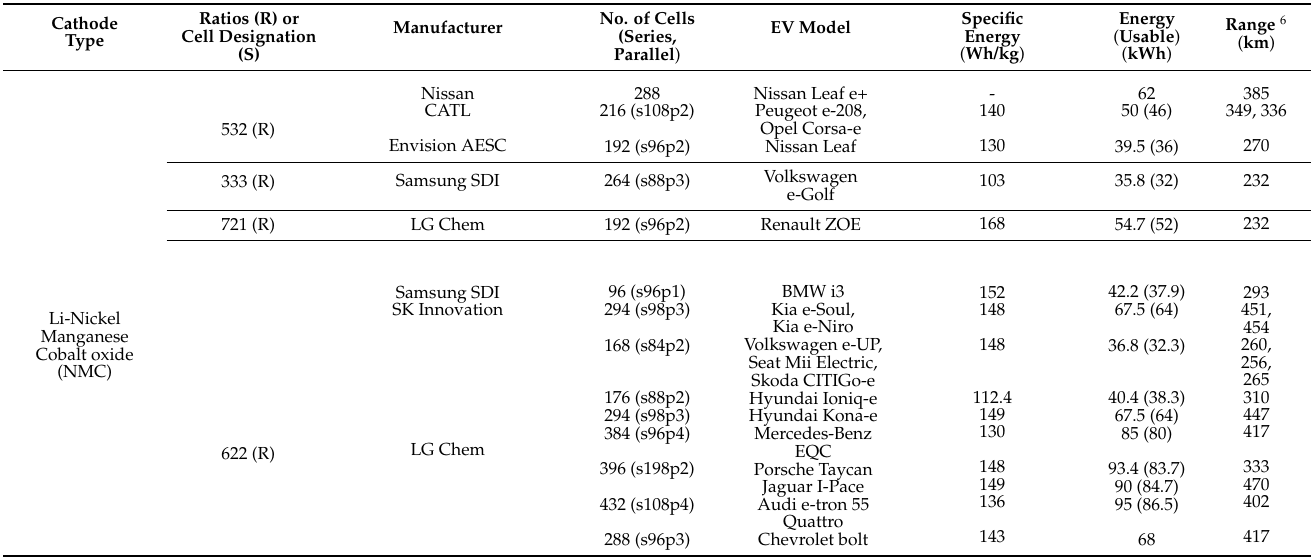
Table 3. NMC cathodes used in EVs. and their main characteristics [28,32–39]. Also available on the ALBATTS project website